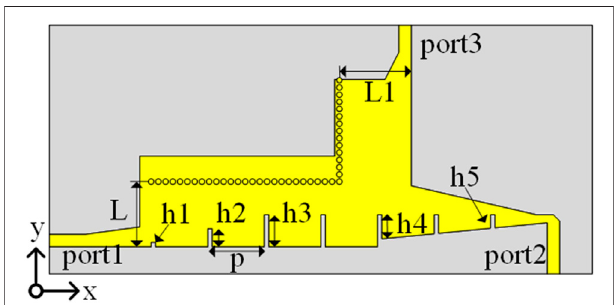
FIGURE 1 | Schematic of the proposed unequal fi ltering power divider.